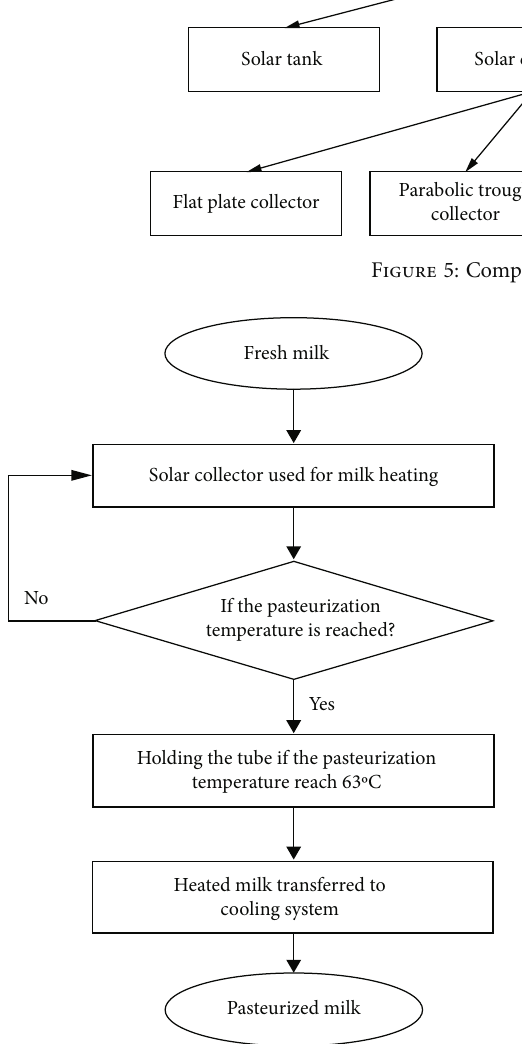
Figure 6: Process fl ow diagram for pasteurized